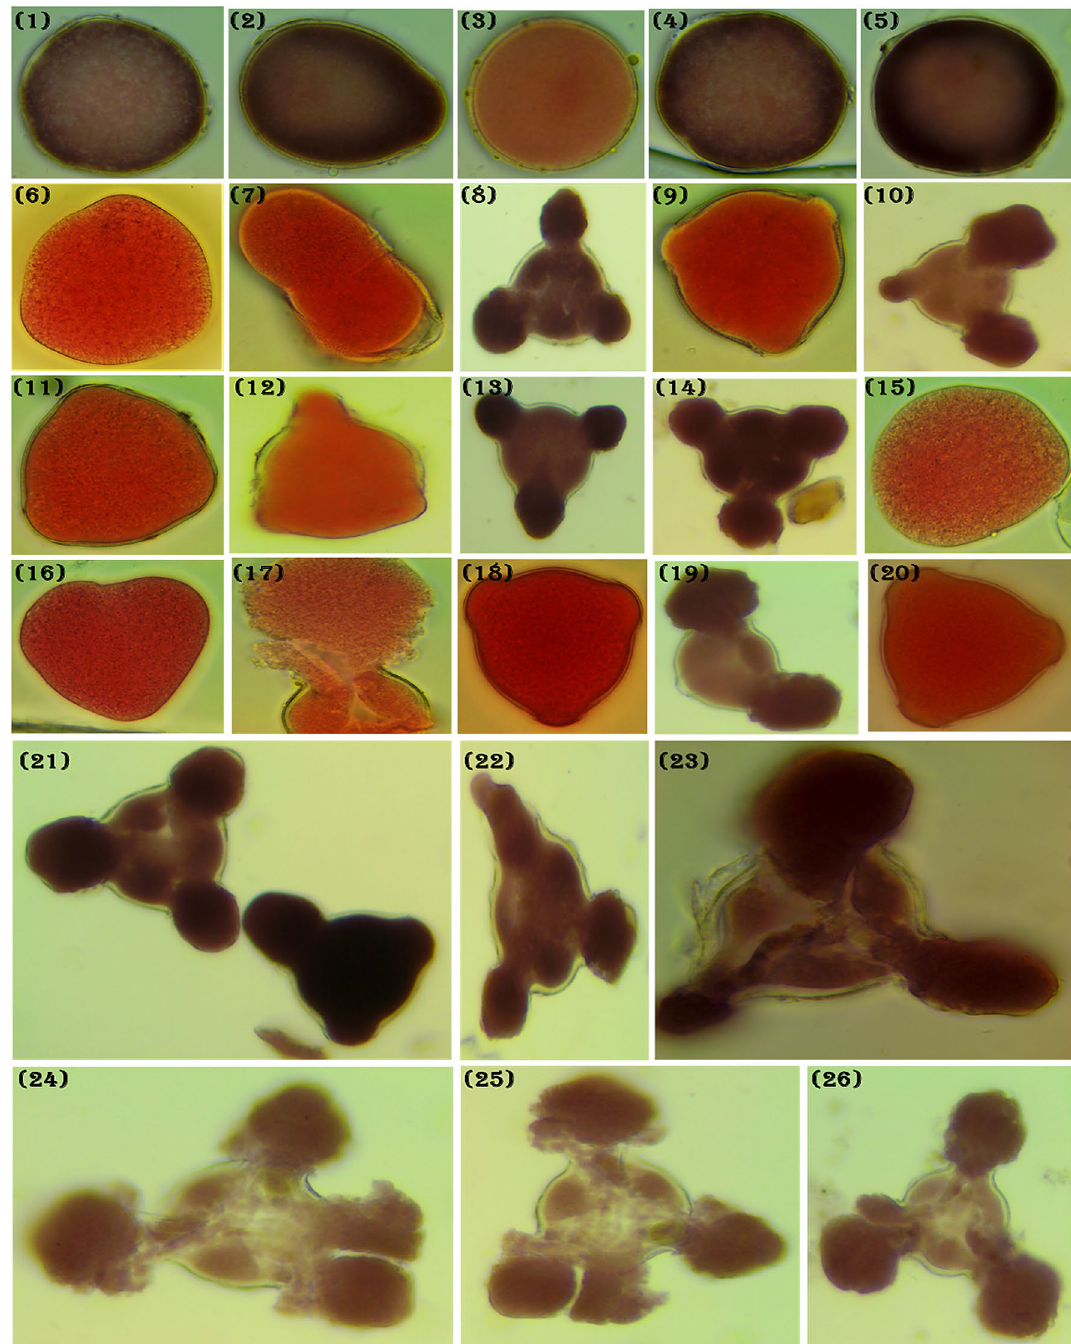
Figure 6. Showing the pollen grains viability and aberration of Ag- NPs (LINS-MF14) as follow: ( 1 – 5 ) control, ( 6 – 10 ) 10 mL/L, ( 11 – 15 ) 12.5 mL/L, ( 16 – 21 ) 15 mL/L and ( 21 : 26 ) showing the high pollen fertility and increase of spore numbers on Florida prince” peach cultivar during 2020 season (100